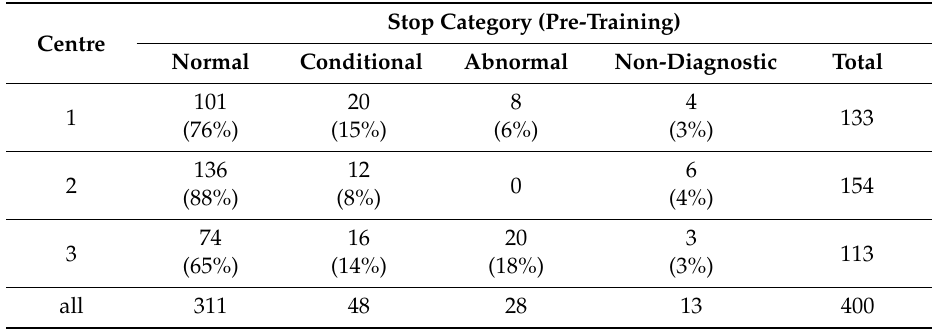
Table 2. The STOP distribution at the three centres, prior to operators attending the TCD training course and including both imaging and non-imaging TCD